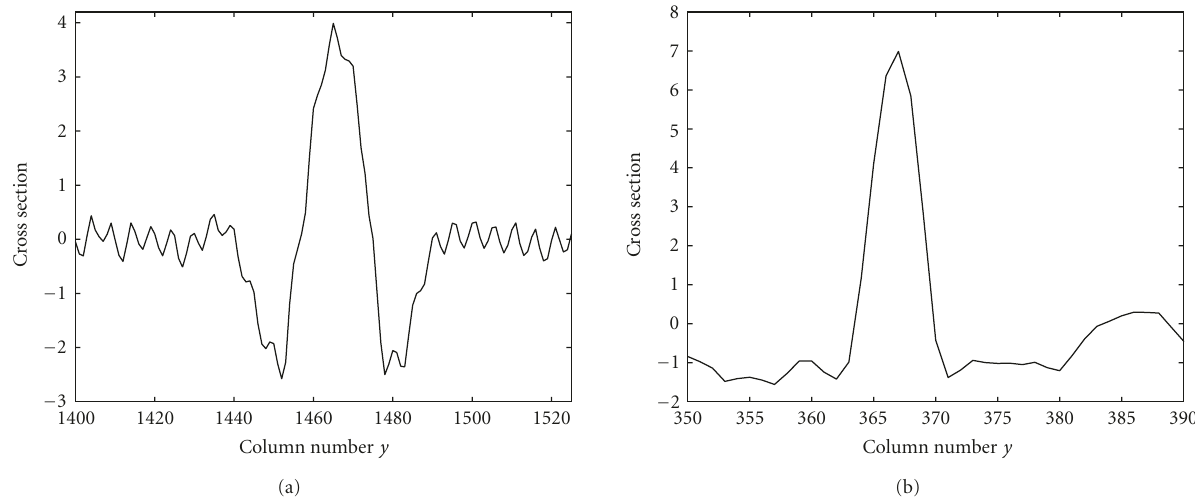
Figure 6: (a) Cross-section in the neighborhood of the red scratch in Figure 2 of the original degraded image—the high frequency may alter detection results since they depend on the local extrema of the signal. (b) Cross-section of the same scratch derived from the original image critically sampled by four: the shape of the scratch is evident and it is well defined by the model in (3). Notice that the length of the critically subsampled signal is 1 / 4 of the full length